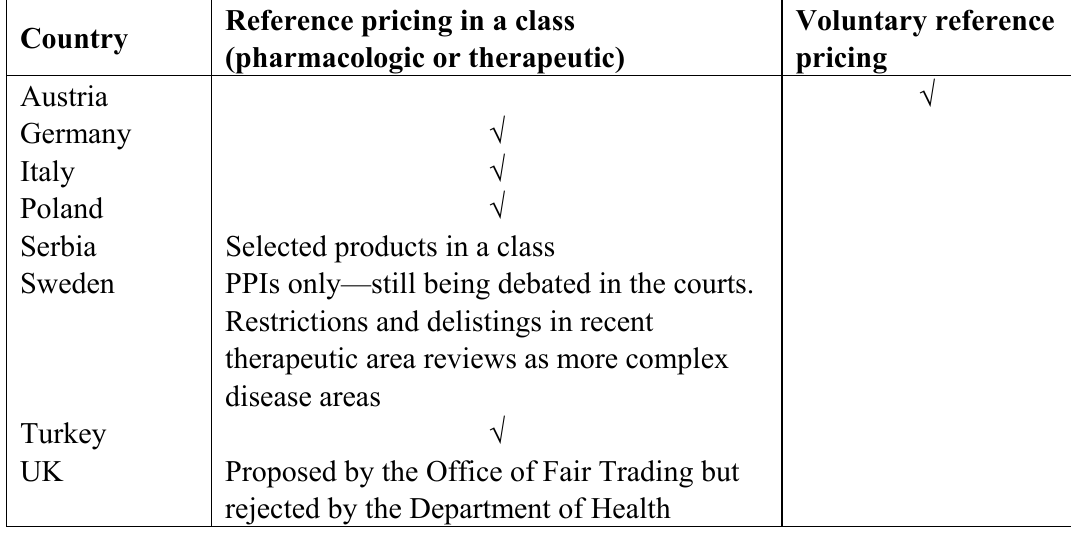
Table 3. Reference pricing in classes in exemplar